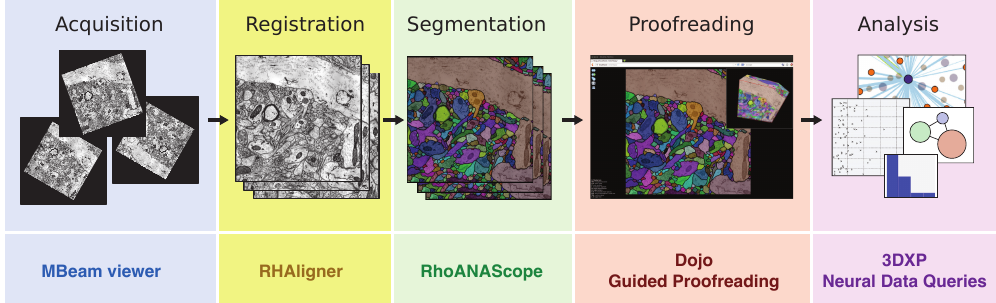
Figure 1. The typical connectomics workflow includes several steps: image tiles of brain tissue are acquired using an electron microscope, registered in 2D and 3D, and automatically segmented into neurons. Since the output of the automatic segmentation is not perfect, it is mandatory to proofread the result prior open source software tools (listed below each